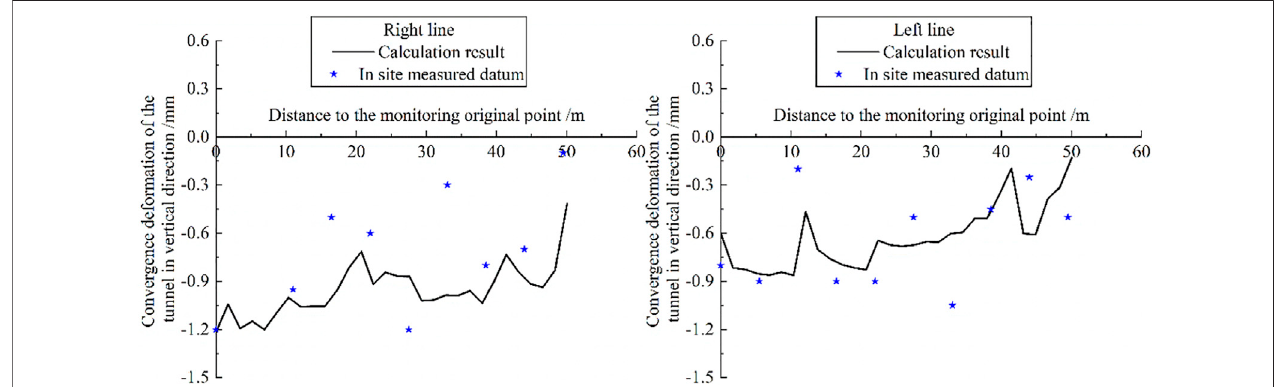
FIGURE 15 | Vertical clearance convergence deformation contrast between the calculation result and the in site measured data.